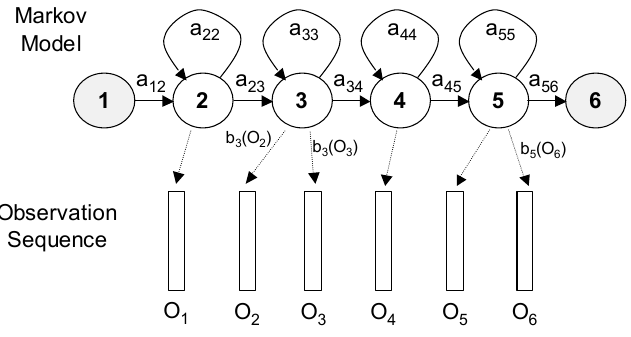
Figure 2. Example of a Hidden Markov Model.